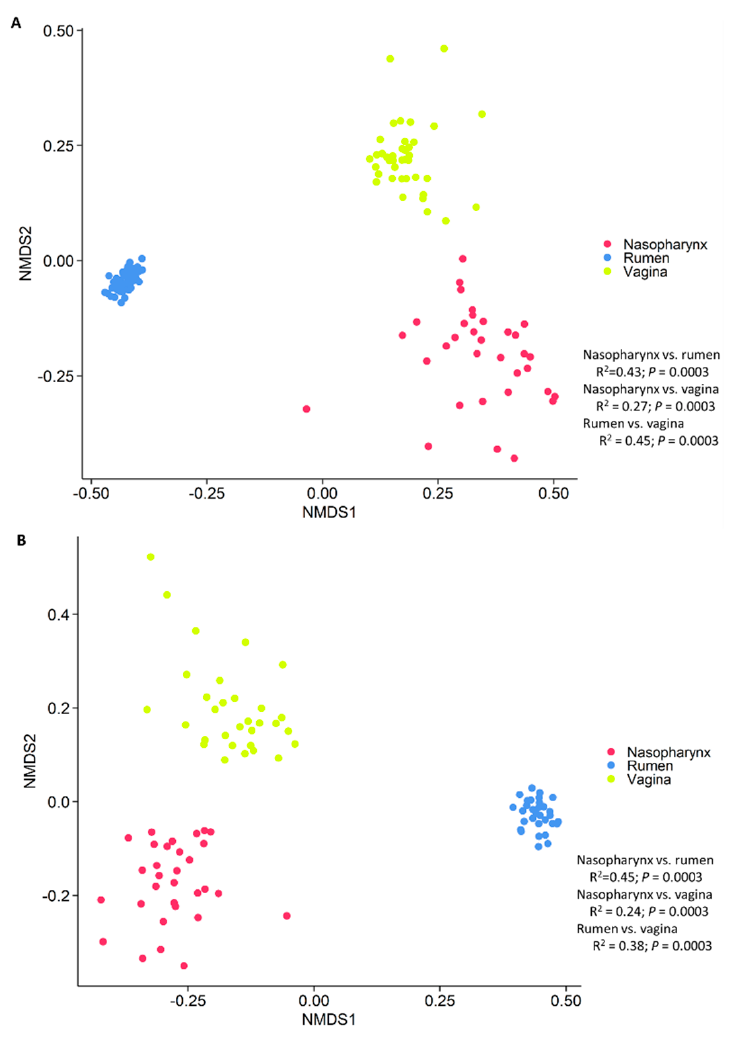
Figure 4. Non-metric multidimensional scaling (NMDS) plots of the Bray–Curtis dissimilarities of the nasopharyngeal, ruminal and vaginal microbiota of ( A ) virgin yearling and ( B ) pregnant heifers. Many taxa appeared to be highly specific to one of the three microbial habitats as shown in the heatmap (Figure 5). For example, OTUs classified as Prevotella , Papillibacter , Oscillospiraceae NK4A214 group and Pseudobutyrivibrio were more exclusively present in the rumen. While the most of the OTUs within the archaeal Methanobrevibacter genus were present in three sampled habitats, the rumen was most predominantly colonized by mem- bers of this genera. Some taxa, including Mycoplasma , Filobacterium , Streptomyces , Nocardi- oides , Marmoricola , Arthrobacter and Cellulomonas spp. , were associated with the nasophar- ynx. Certain Corynebacterium OTUs appeared to be specific to the vaginal microbiota. Although the nasopharyngeal, ruminal, and vaginal microbiota were clearly distinct, a small number of taxa were present in all three microbial communities. We identified 43 OTUs that were shared by more than 60% of all samples from the virgin yearling heifers (Table S1). From these OTUs, two were classified as Methanobrevibacter (OTU8 and OTU23). The remaining shared OTUs were bacterial in origin, with 17% and 80% of them belonging to the Actinobacteriota and Firmicutes phyla, respectively. Of note, three bacterial OTUs (OTU25 ( Eubacterium coprostanoligenes group; OTU561( Colidextribacter ) and OTU29 ( Ruminococcus )) were shared by more than 90% of the samples. In pregnant heifers, 47 OTUs were present in more than 60% of all samples (Table S2), and most of them were identical to those taxa shared among the virgin yearling heifer samples. One taxon iden- tified as Romboutsia ilealis (OTU11) was found in 100% of the samples, and OTU24 ( Paeni- clostridium ), OTU25, OTU29 and OTU68 ( Bifidobacterium pseudolongum ) were identified in 95% of the samples.